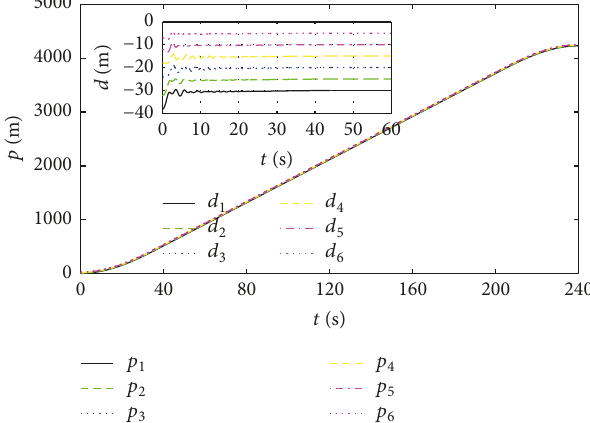
Figure 4: Control inputs of vehicles with actuator saturation in vehicle platoon.